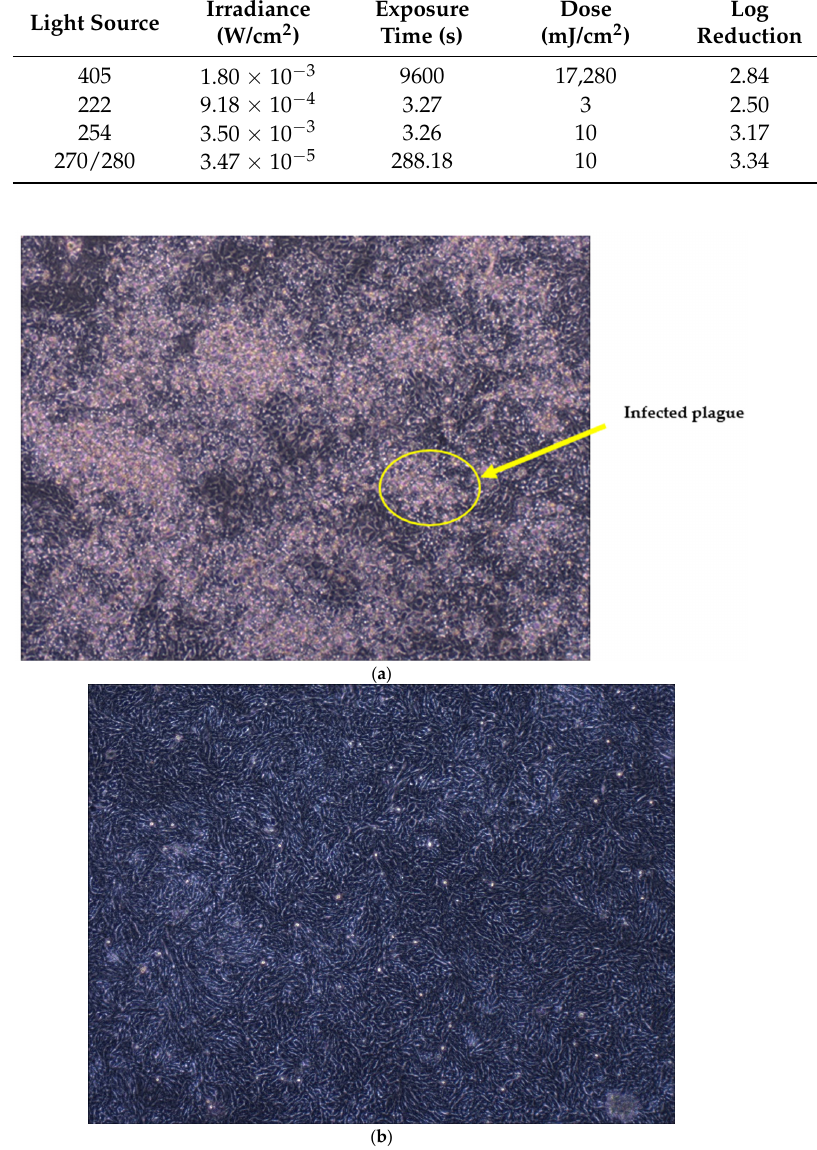
Figure 5. The basic infectivity test result of the control sample, i.e., the viral sample not exposed to any UVC radiation or visible blue light and the viral sample exposed to UVC. ( a ) Control sample showing the infected plague of the virus. The control sample was kept at 4 °C at the testing facility. ( b ) Viral sample exposed to a 10 mJ/cm 2 dose of 270/280 nm, showing much less infected plague compared to the control sample.